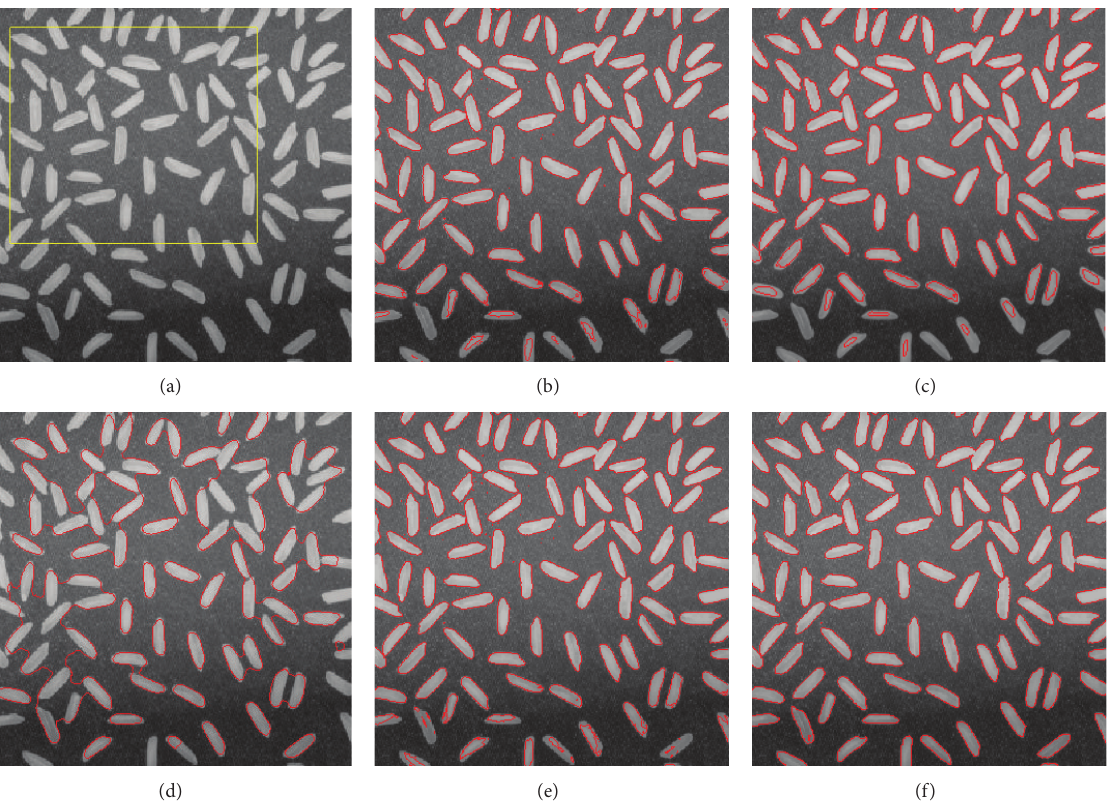
Figure 14: Segmentation results on the rice image: (a) the initial contour, (b) the CV model result, (c) the GACV model result, (d) the DRLSE model result, (e) the FAC model result, and (f) the LFAC model result.